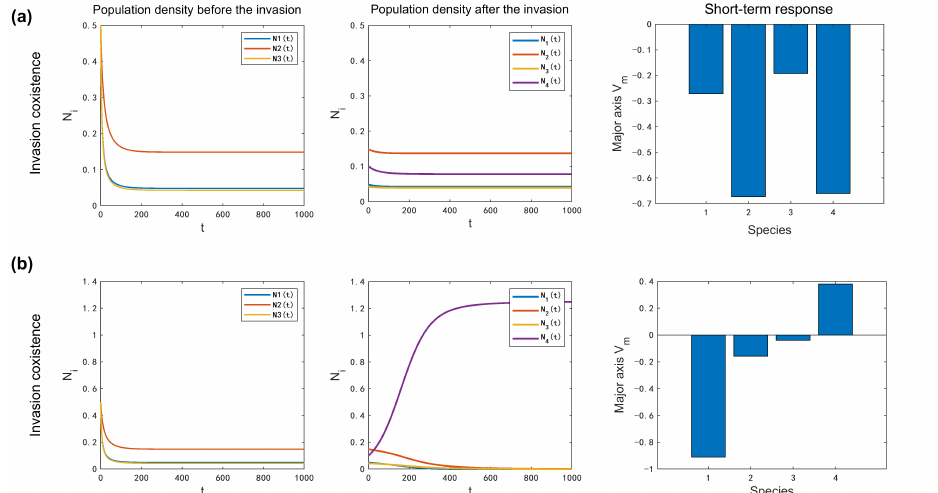
Figure 4. The long-term evolution dynamics and short-term response of all species in case 1 and θ = 0.3. We respectively choose parameter values from obtained two invasion consequences, ( a ) invasion coexistence and ( b ) invasion exclusion of this scenario. The first two columns respectively show long-term population evolution before and after invasion. The last column corresponds to the major axis (i.e., the eigenvector of the lead eigenvalue) of the joint matrix, revealing how each species dynamically responds to the invasion (species 1–3 are the original resident species; species 4 is the newly introduced species). r 1 = r 2 = r 3 = 0.02. α 14 and α 44 are randomly selected in the corresponding invasion result area.